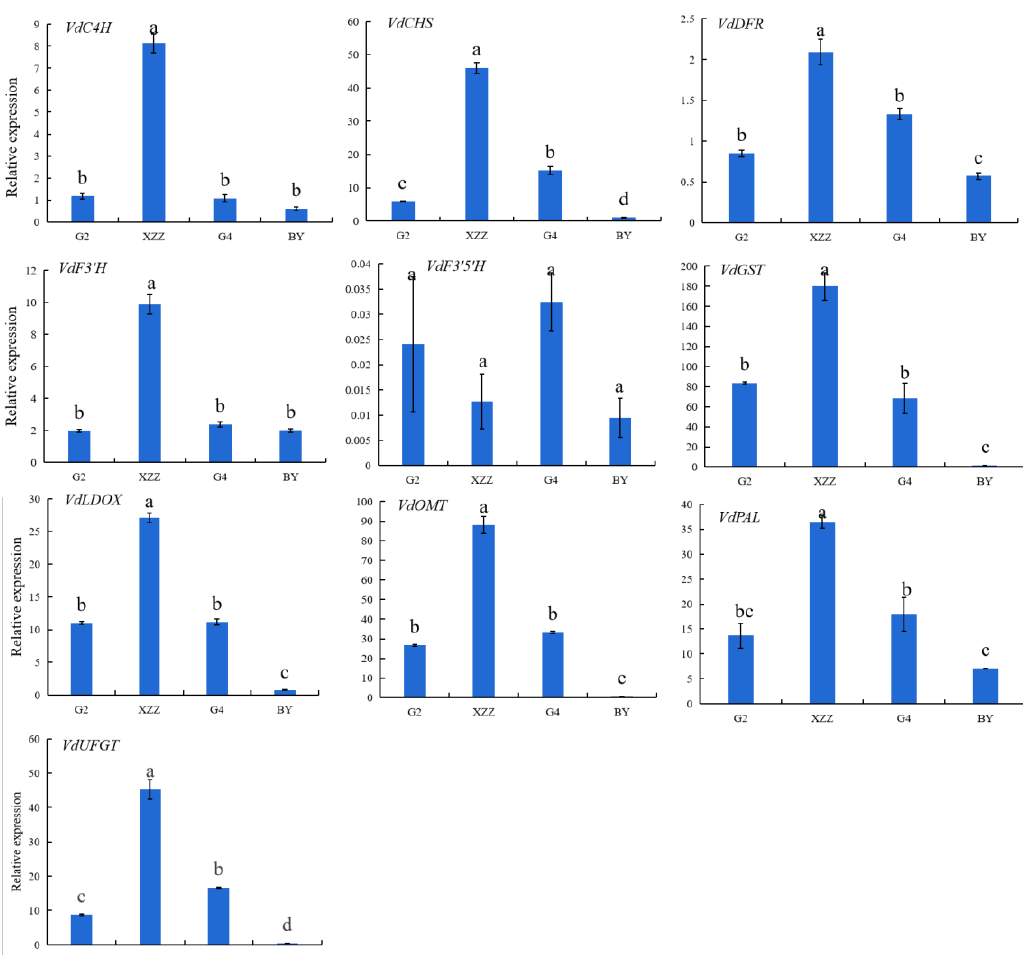
Figure 2. Expression levels of key genes involved in anthocyanin biosynthesis of spine grapes. Values presented are means ± SD ( n = 3). VdGAPDH was used as reference gene. Different letters indicate significant differences among four spine grapes using Duncan’s test ( p < 0.05). G2: Gaoshan #2, G4: Gaoshan #4, XZZ: Xiangzhenzhu, BY: Baiyu.